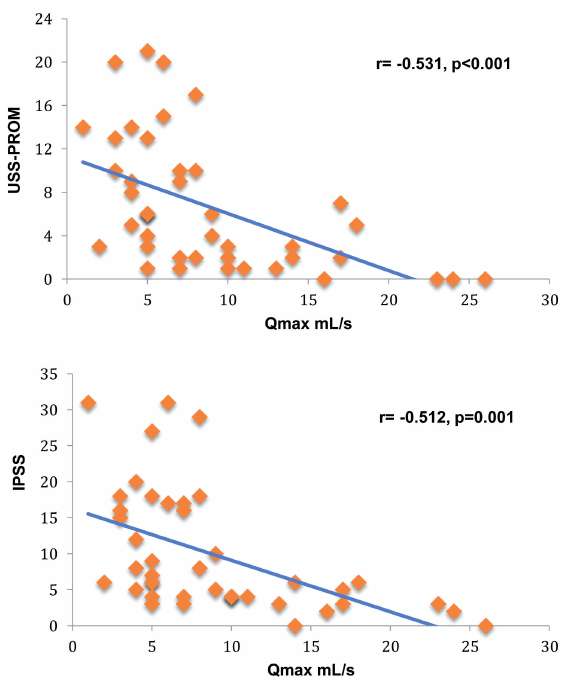
Figure 1 – Correlations between USS-PROM and IPSS scores with Qmax showing strong negative